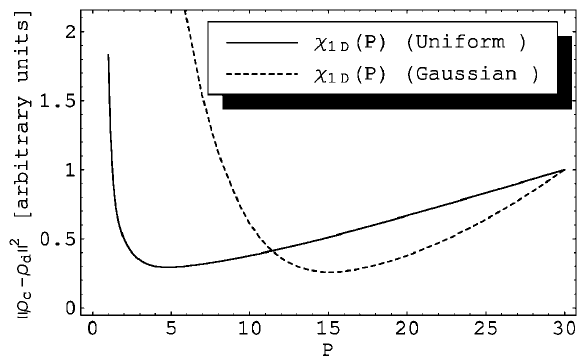
(cid:4) P (cid:5) as defined in Eqs. (55) and (57) and of 4. Plots of . 1D (cid:4) P (cid:5) as defined in Eq. (64) (for N (cid:6) 36 , 10 2 , and 10 3 ). The / 1D macroscopic distribution is assumed to be uniform, and macro- particles are placed at equally spaced positions. The functions have been rescaled to have the same value at the right edge of the scale.